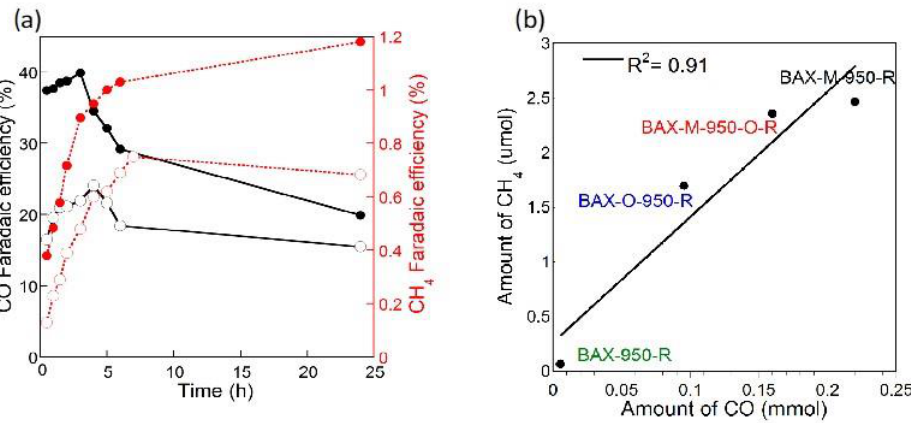
Figure 5. ( a ) Increase in the Faradic efficiency for CO and CH 4 formation on nitrogen-modified commercial carbon upon duration of a catalysts electroreduction process prior to CO 2 ERR, and ( b ) dependence of the amount of CH 4 formed upon the amount of CO formed. Adapted with permission from Reference [47]. Copyright 2017, Elsevier.